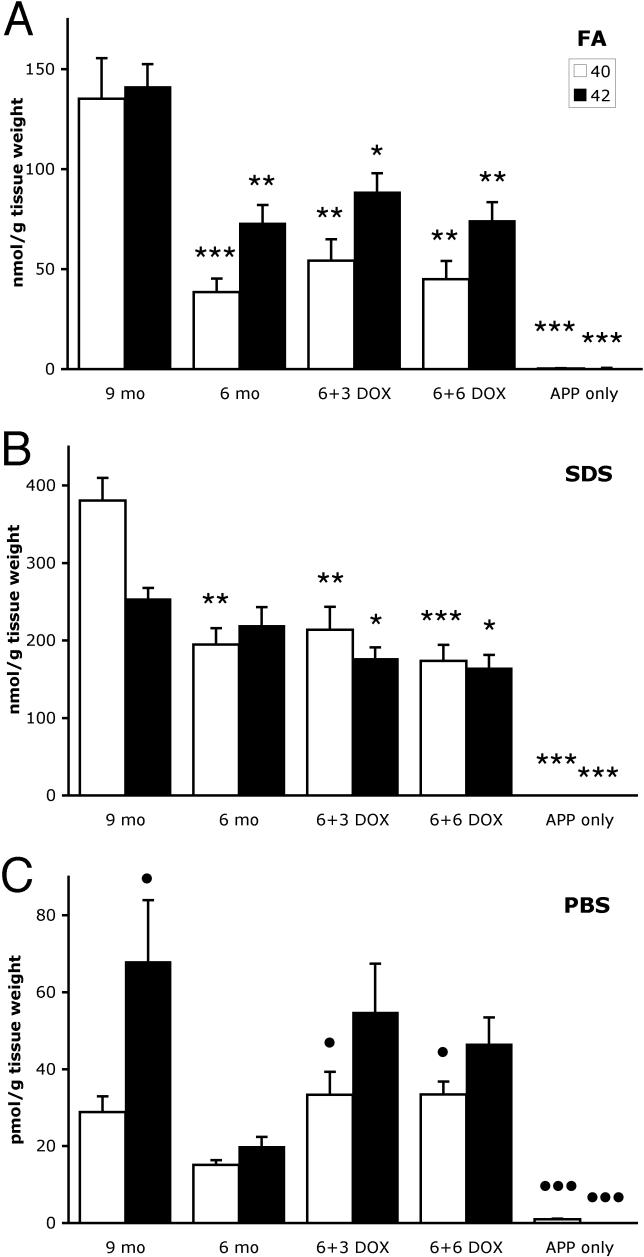
Aβ ELISA Confirms Arrest of Progression without Clearance of Peptide in Mice with Preexisting AggregatesAβ levels in untreated 6- and 9-mo-old tTA/APP line 107 mice (shown in Figure 4) were compared to those in 9- and 12-mo-old animals treated with dox from the age of 6 mo. Single transgenic APP samples were included as negative controls. Cortical homogenates were fractionated by sequential multi-step extraction with PBS, 2% SDS, and 70% FA followed by human-specific Aβ ELISA to measure transgene-derived peptide in each fraction. Aβ40 is shown in white, Aβ42 in black.(A and B) Most Aβ in the brains of plaque-bearing mice is extracted into the FA and SDS fractions. Consistent with amyloid burden (Figures 4 and Figure S3), SDS- and FA-extracted Aβ levels in untreated 9-mo-old mice were significantly higher than in untreated 6-mo-old mice (Tukey post-hoc test applied to significant effect of group ANOVA for SDS and FA fractions F
3,18 = 4.72–12.92, p < 0.02). In contrast, 3 or 6 mo of transgene suppression held Aβ at levels equivalent to those harbored when treatment was started (p > 0.2 compared to 6 mo untreated mice, Tukey post-hoc test). *, p < 0.05; **, p < 0.005; ***, p < 0.001 versus 9-mo-old untreated mice, Tukey post-hoc test. Significance for APP versus 9-mo-old untreated mice is based on Student's t-test.(C) The PBS fraction represents less than 0.1% of total Aβ (note the change in y-axis from [A] and [B]), but only here do Aβ levels in the dox-treated mice differ from those in younger untreated mice. Although both peptides appear elevated in the treated groups compared to the untreated 6-mo-old mice, only Aβ40 reaches statistical significance (p < 0.05, Tukey post-hoc test applied to significant effect of group ANOVA for Aβ40 F
3,18 = 4.60, p < 0.02). A similar trend was seen for Aβ42, where ANOVA yielded a significant effect of group for PBS-soluble Aβ42 (F
3,18 = 3.75, p < 0.03), however this was due only to differences between the untreated 6- and 9-mo-old groups. •, p < 0.05 versus 6-mo-old untreated mice, Tukey post-hoc test; •••, p < 0.001 versus 6-mo-old untreated mice, Student's t-test.